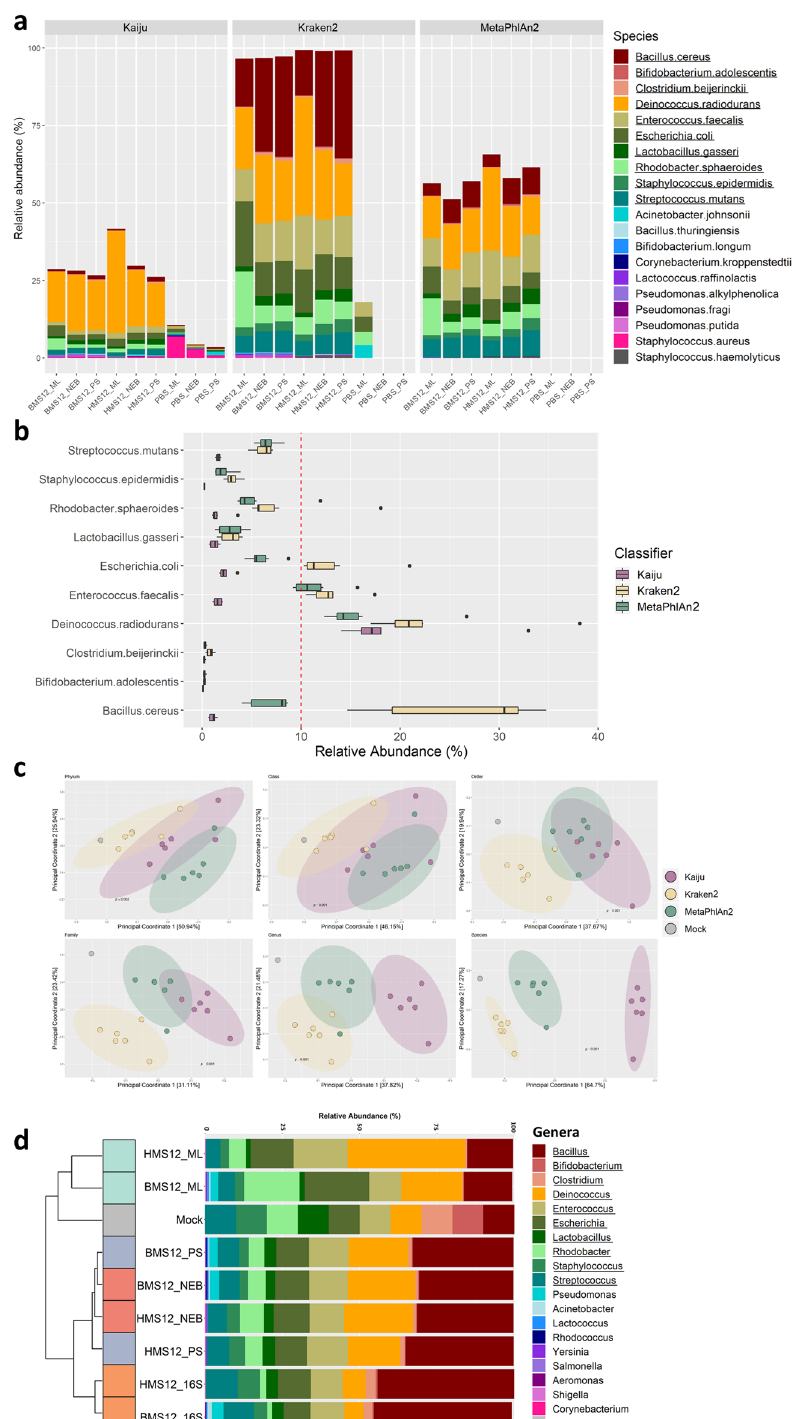
Figure 3. Mock community samples impacted by choice of bioinformatics classifier rather than method. ( a ) Top 20 species by relative abundance of non-host reads are displayed as determined by three different taxonomic classifiers. Unclassified and low abundance species account for the non-displayed reads. The species underlined are those present in the spiked mock community. ( b ) Comparison of the relative abundances of the 10 species in the mock community in the spiked milk samples according to each classification tool. Red dotted line indicates the expected 10% mark. ( c ) Bray–Curtis dissimilarity plots of all 6 spiked mock community samples, coloured by classifier, for each taxonomic rank. The expected mock community composition is in grey. Significant differences are noted with their p value as calculated using ADONIS. ( d ) Top 20 genus level microbial composition of each spiked milk community as determined by both shotgun metagenomics as classified using Kraken2 and 16S rRNA amplicon sequencing. Genera underlined are those present in the spiked mock community. Samples are clustered based on Bray–Curtis dissimilarity with expected mock community included. Figures were produced using R 48